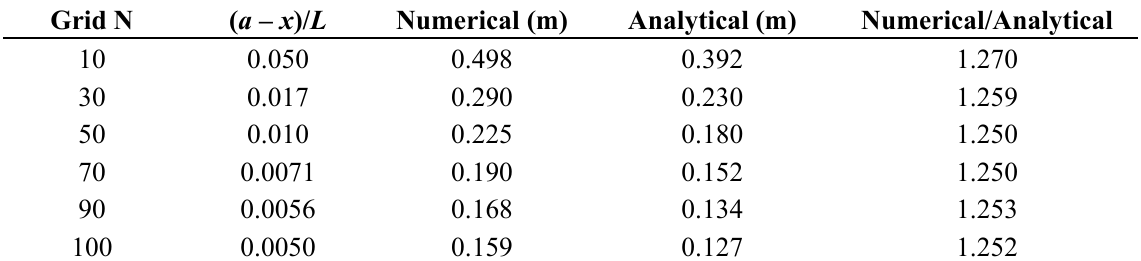
Table 2. The comparison of numerical modelling with analytical solution for the aperture of tip element. Here x is the coordinate of the center of tip